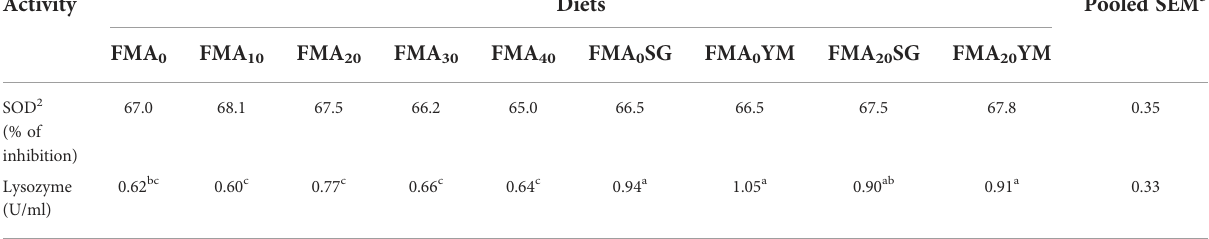
TABLE 4 Non-speci fi c immune responses in juvenile Japanese eel fed with the experimental diets for 8 weeks 1 . Activity Diets